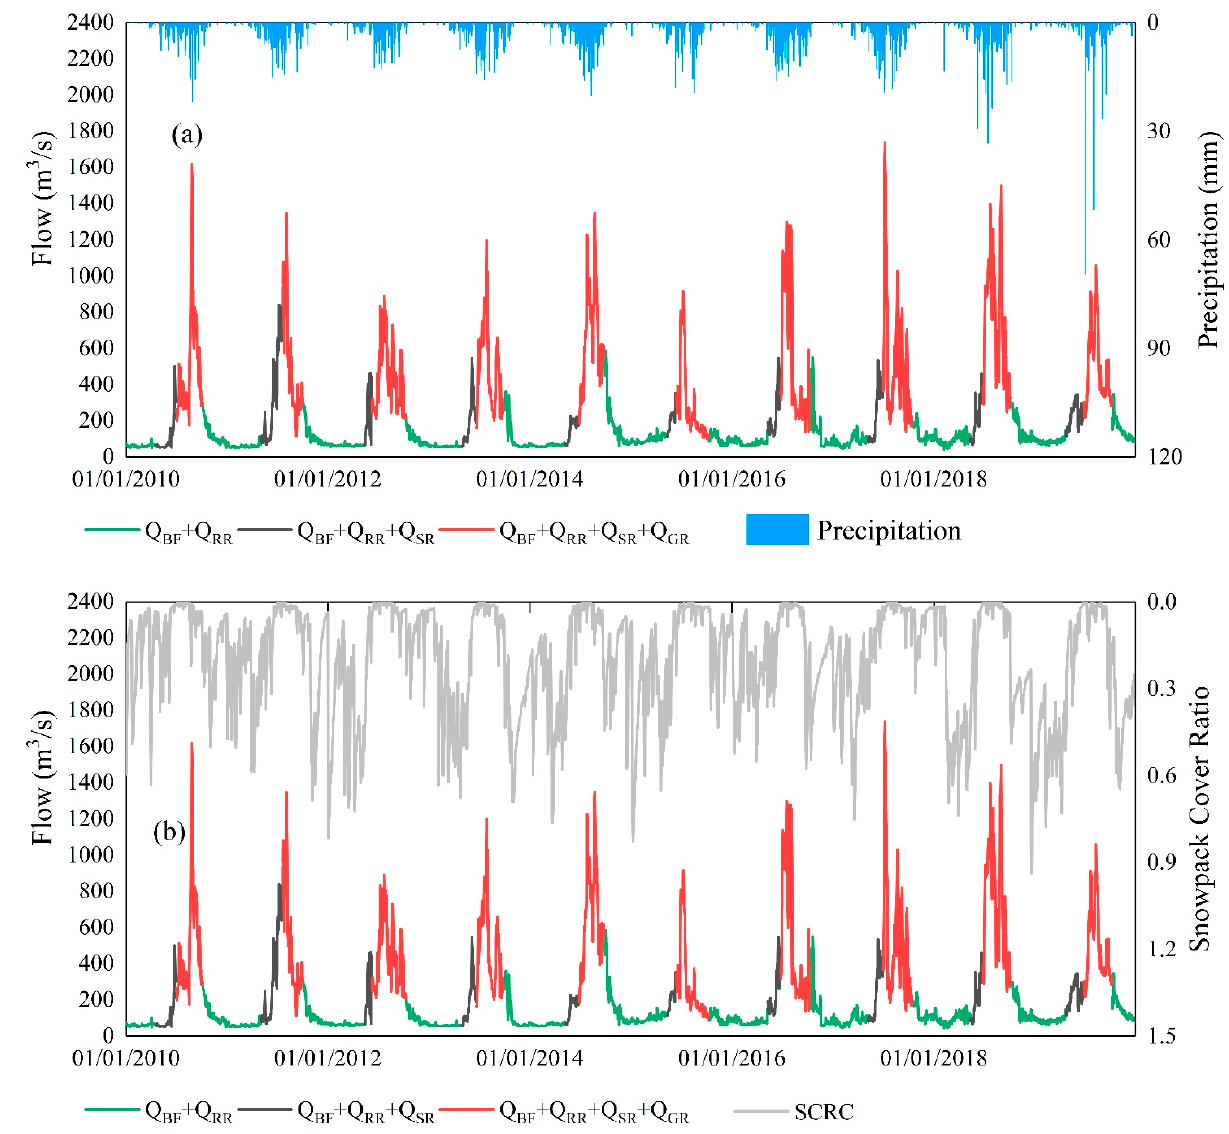
Figure 3. Hydrograph partitioning curves extracted at the TANGJIA station in 2010–2019. ( a ) represents the measured runoff of the TANGJIA hydrological station from 2010 to 2019 divided by the HPC method. ( b ) compares the measured runoff division results at the TANGJIA hydrological station and the proportion of snow cover area from 2010 to 2019.